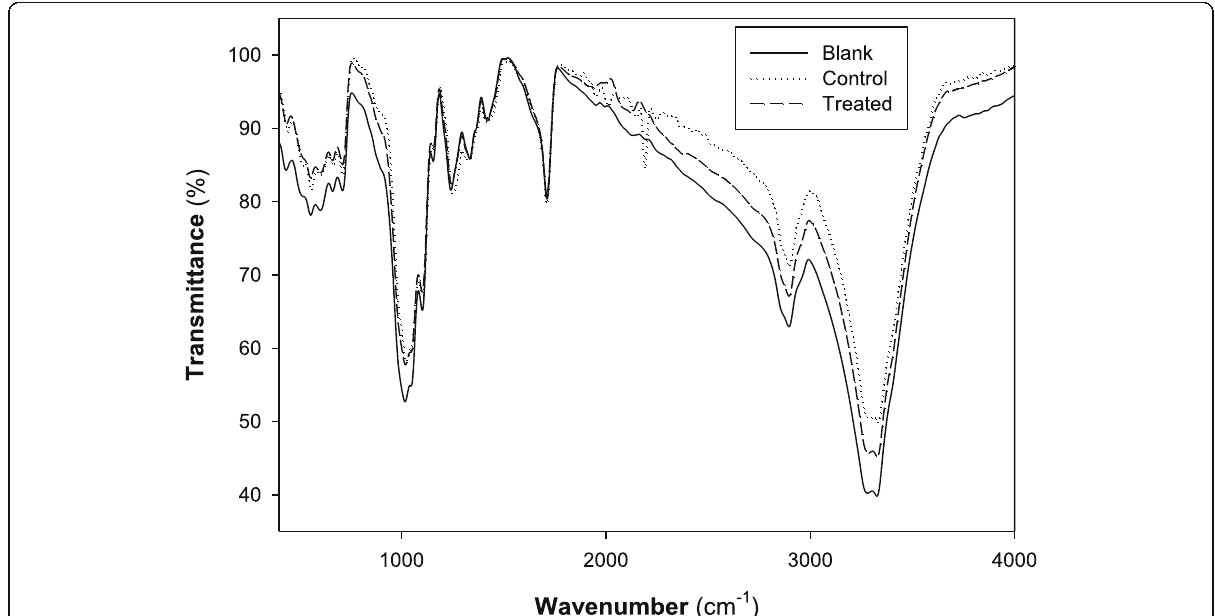
Fig. 7 FTIR spectroscopy of the textiles treated with biosynthesized AgNPs. PET/C hydrolyzed by cellulase (Blank), PET/C hydrolyzed by cellulase and then treated by A. fumigatus CFF (Control), and PET/C hydrolyzed by cellulase, then treated by A. fumigatus biosynthesized AgNPs